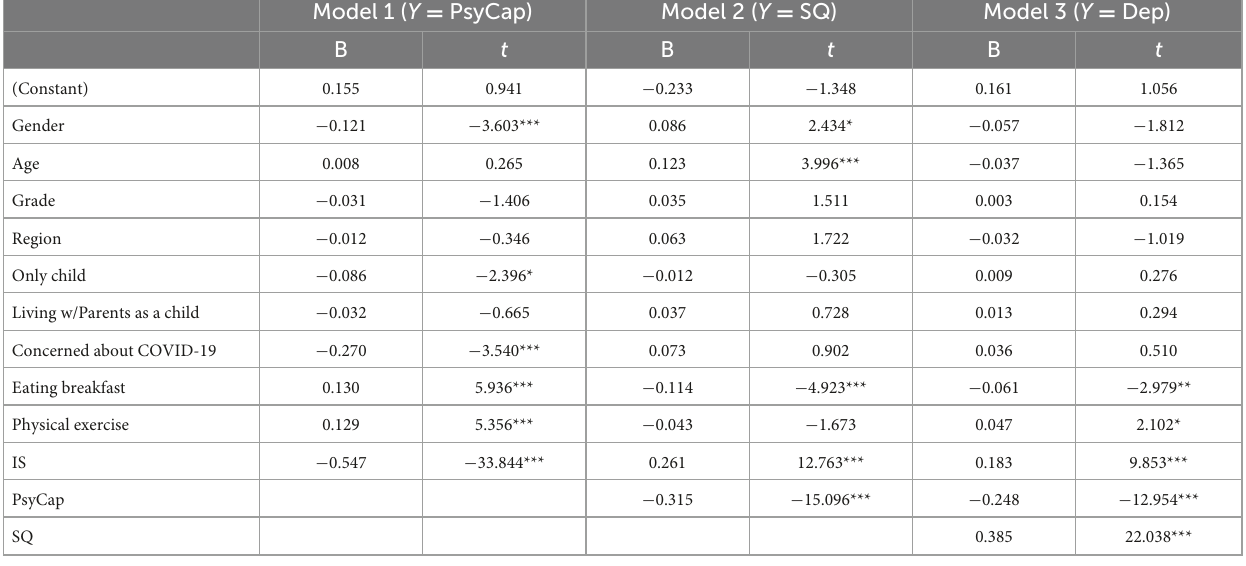
TABLE 3 Model characteristics of the serial multiple mediation